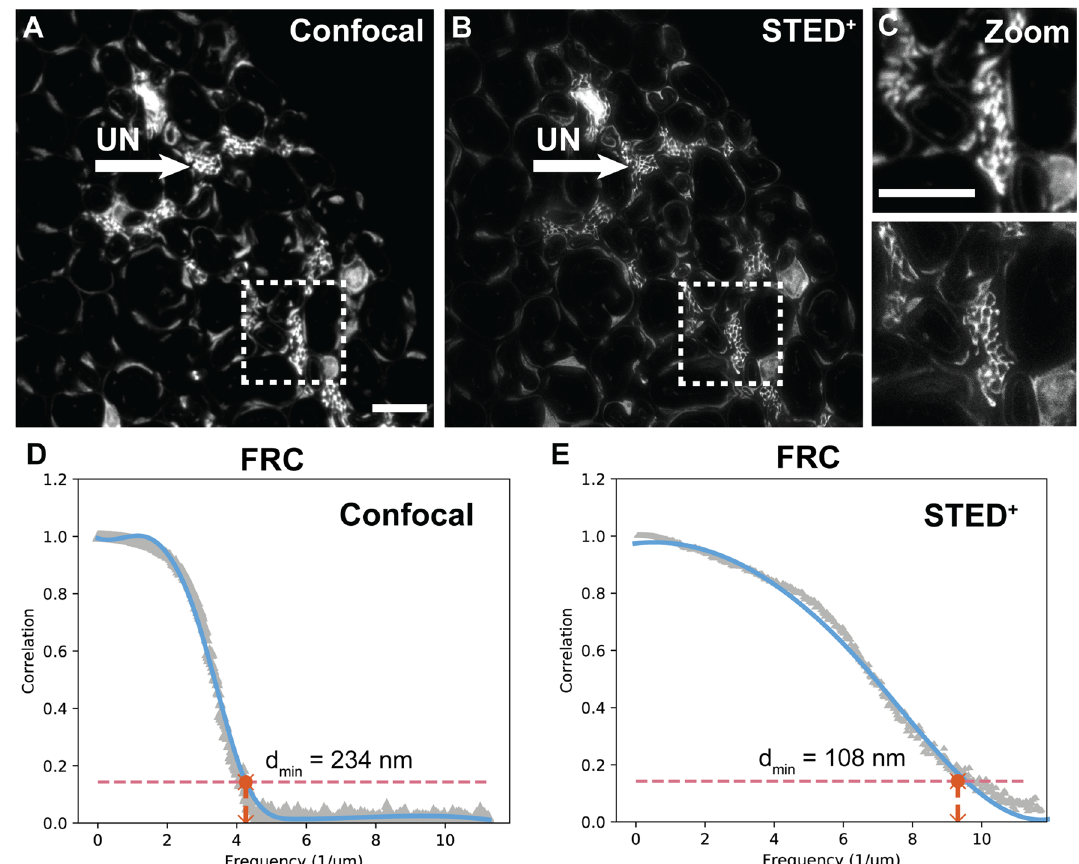
Figure 4. Super-resolution imaging of murine sciatic nerve cross-sections. ( A–C ) Fluorescent images of Sox10-Venus sciatic nerve imaged using confocal fluorescence and STED microscopy demonstrates resolution enhancement of unmyelinated fibers. Marked examples of unmyelinated fibers (UN, arrow) in the images. Resolution estimation using FRC. Scale bar 5